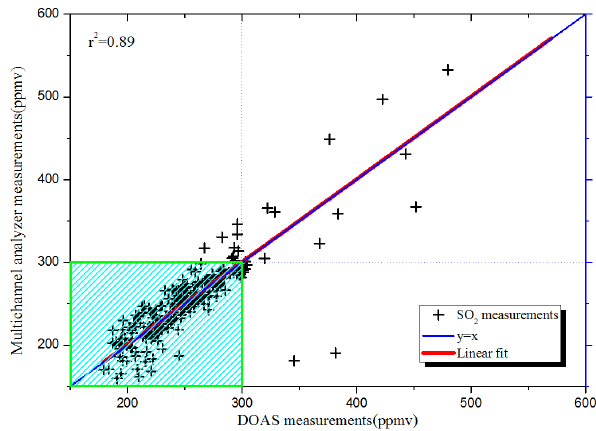
Figure 17. Time series of hourly averaged SO 2 concentrations mea- sured with the DOAS analyzer and the multichannel analyzer at the Shangfeng cement plant.